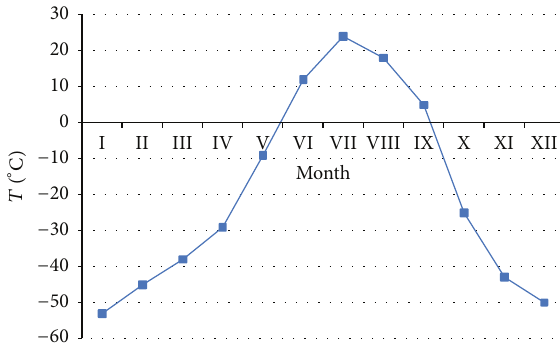
Figure 5: Minimal average month temperatures per five years in Tommot